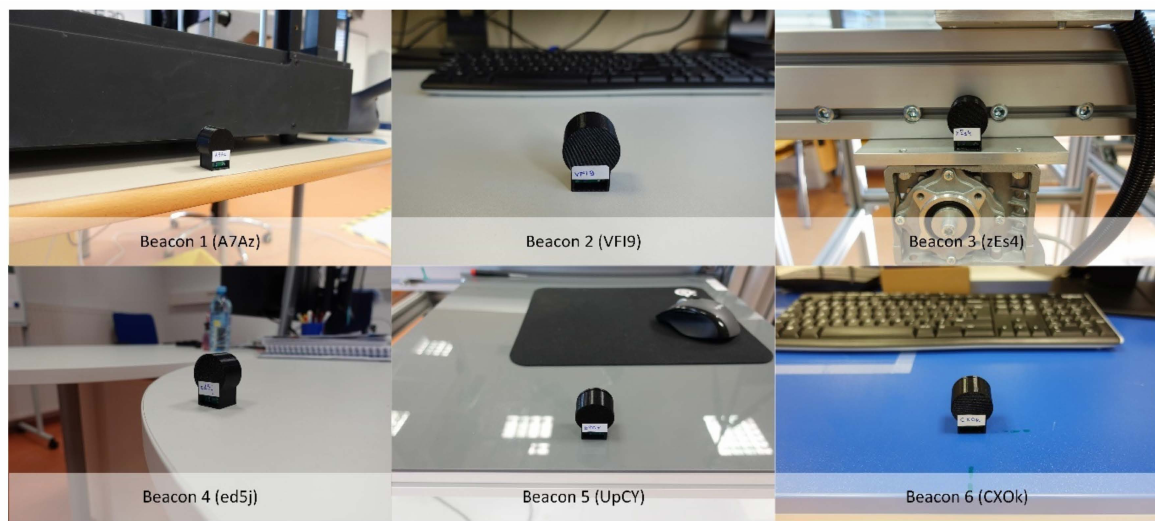
Figure 9. Position of the selected beacons for the